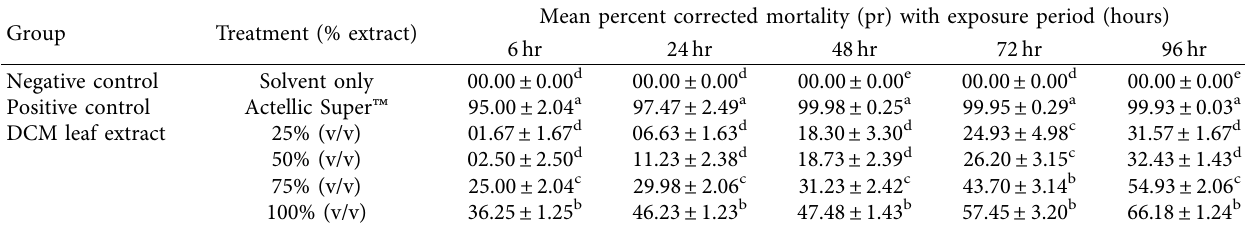
Valuesareexpressedas mean ± SEMfor fourreplicatespergroup ( n � 4).Statisticalcomparisons weremadewithin acolumn,and valuesfollowed bythesame superscripts along the column are not significantly different by one-way ANOVA ( p ≥ 0 . 005) followed by Tukey’s post hoc test. Actellic Super ™ � 50g/90kg of maize grains; solvents � 1ml